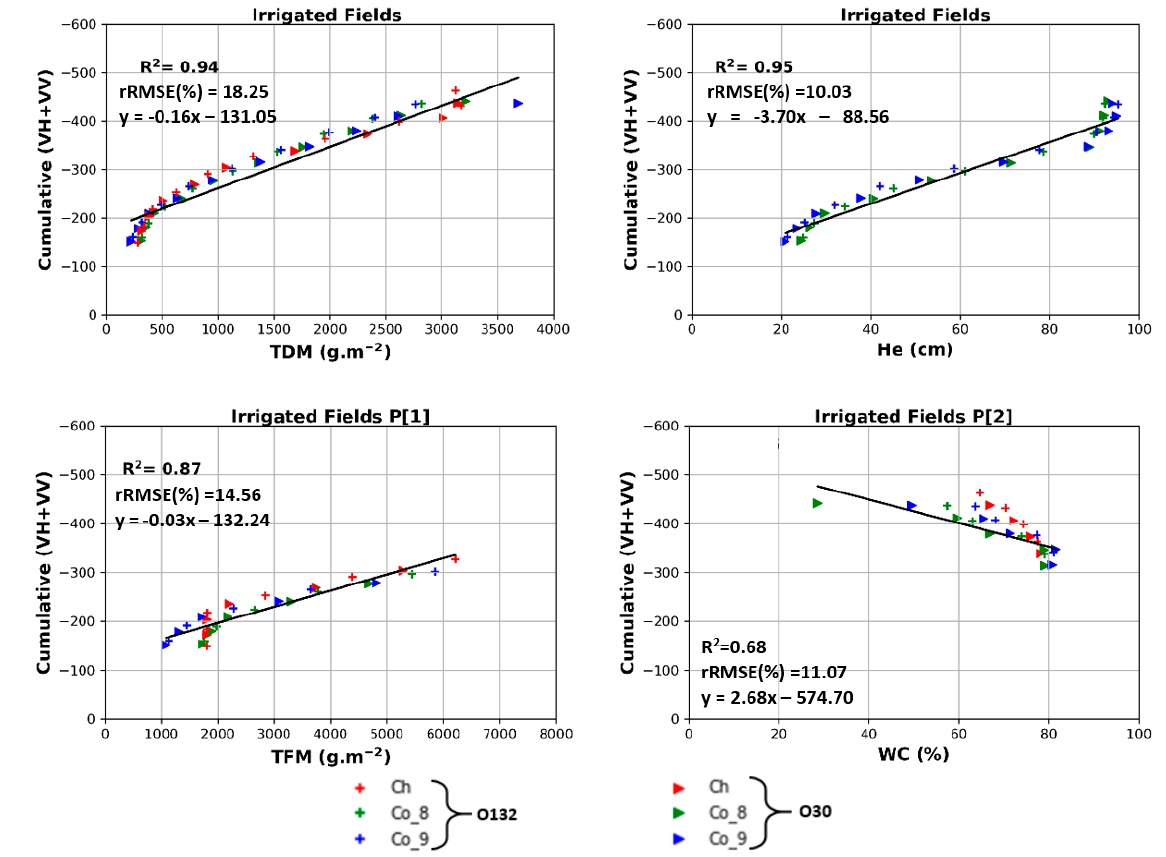
Figure 12. Best sensitivities of the cumulative (VH + VV) index to wheat crop parameters (TDM, He, TFM and WC) for each studied field and the two orbits (O30 and O132).